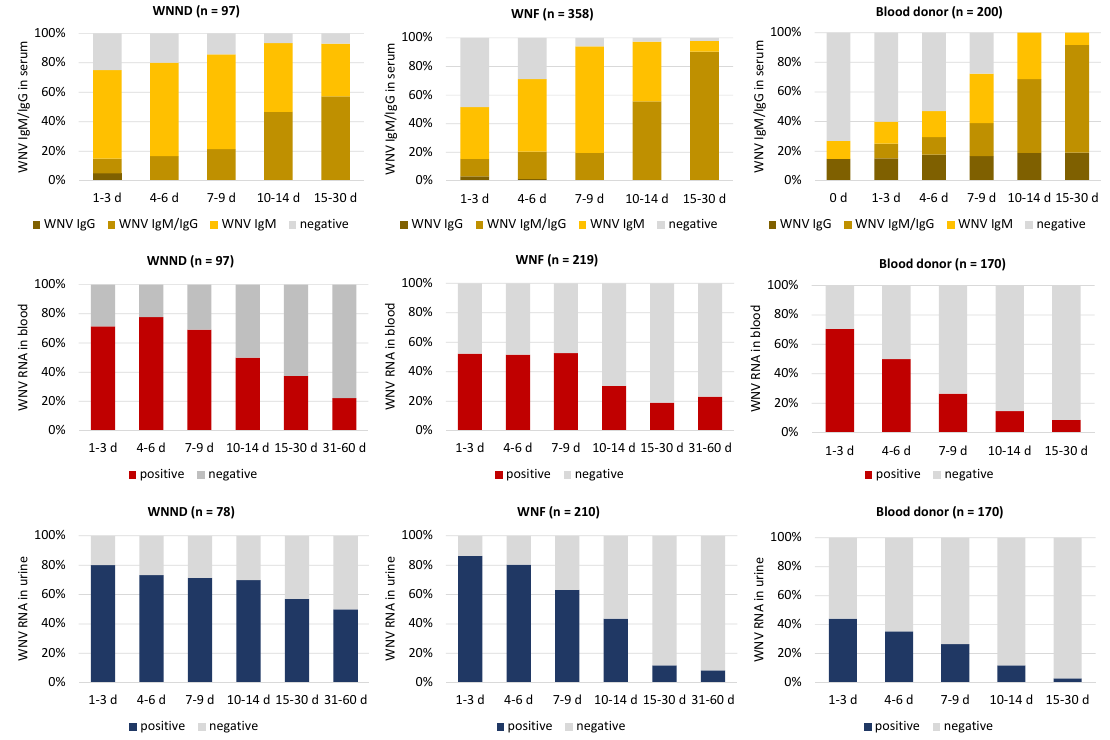
Figure 4. Laboratory findings in human cases of WNV infection according to the time since the onset of symptoms or WNV NAT-positive index blood donation, Veneto region, northern Italy, 2018. Graphs show the percentage of serum samples positive for WNV IgM and / or IgG and percentage of WNV RNA-positive blood and urine samples. The number of tested samples is indicated between brackets. This number is higher than the number of patients because, when available, follow-up samples collected from the same patient were included in the analysis. WNND: West Nile neuroinvasive disease; WNF: West Nile